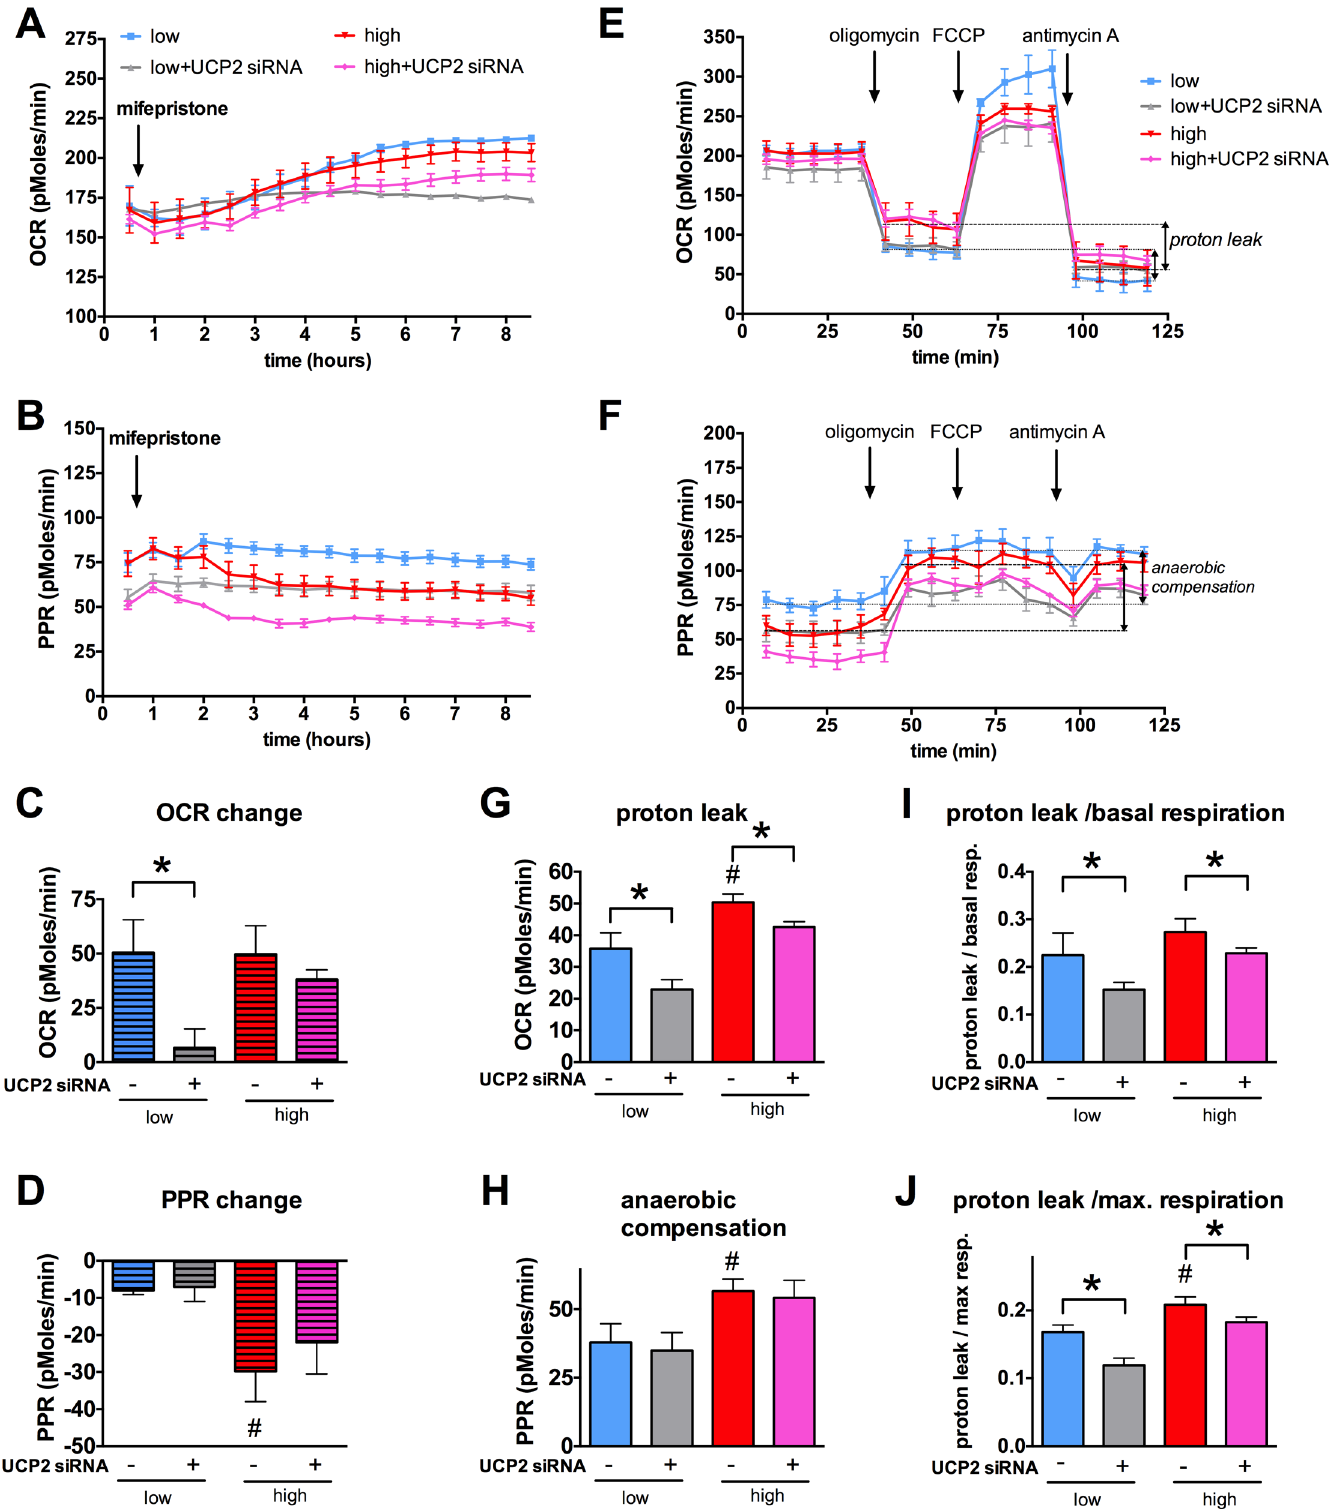
Fig 8. UCP2 silencing blocks the metabolic changes induced by mifepristone. A-H: b.End3 microvascular endothelial cells were transfected with UCP2 siRNA or negative control siRNA and exposed to high glucose for 5 days. A-D : The cells were treated with mifepristone (3 μ M) and A : the cellular oxygen consumption rate (OCR) and B : proton production rate (PPR) was monitored in real time by the Seahorse XF24 Extracellular Flux Analysis